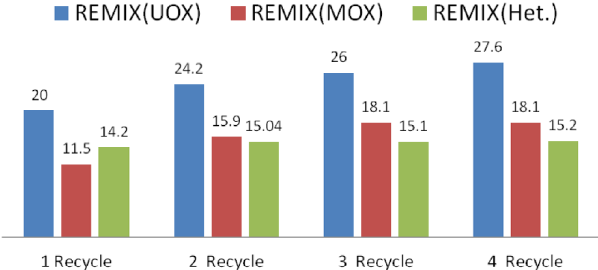
Fig. 4. The natural uranium consumption reduction, %.